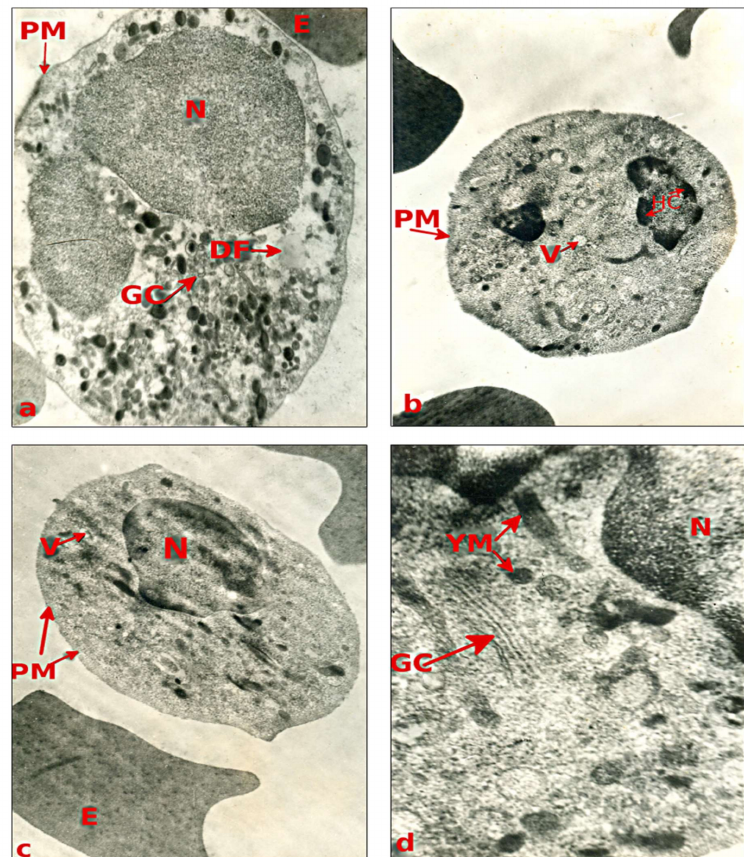
Figure 3. The ultrastructure of peripheral blood granulocytes and lymphocyte in child X, aged 12, with GPP. ( a ) disorganized nucleus (N) and cytoplasm of neutrophil granulocyte, magnification of 7000 × ; ( b , c ) a small number of electron-dense granules against the background of increased electron-dense cytoplasm of neutrophil granulocytes, magnification of 4500 × ; ( d ) fragment of lymphocyte with hypertrophied Golgo complex, magnification of 25,000 × ; V: vesicle; HC: heterochromatin; GC: Golgi complex; DF: drop of fat; YM: young mitochondria. The remaining abbreviations are the same as noted